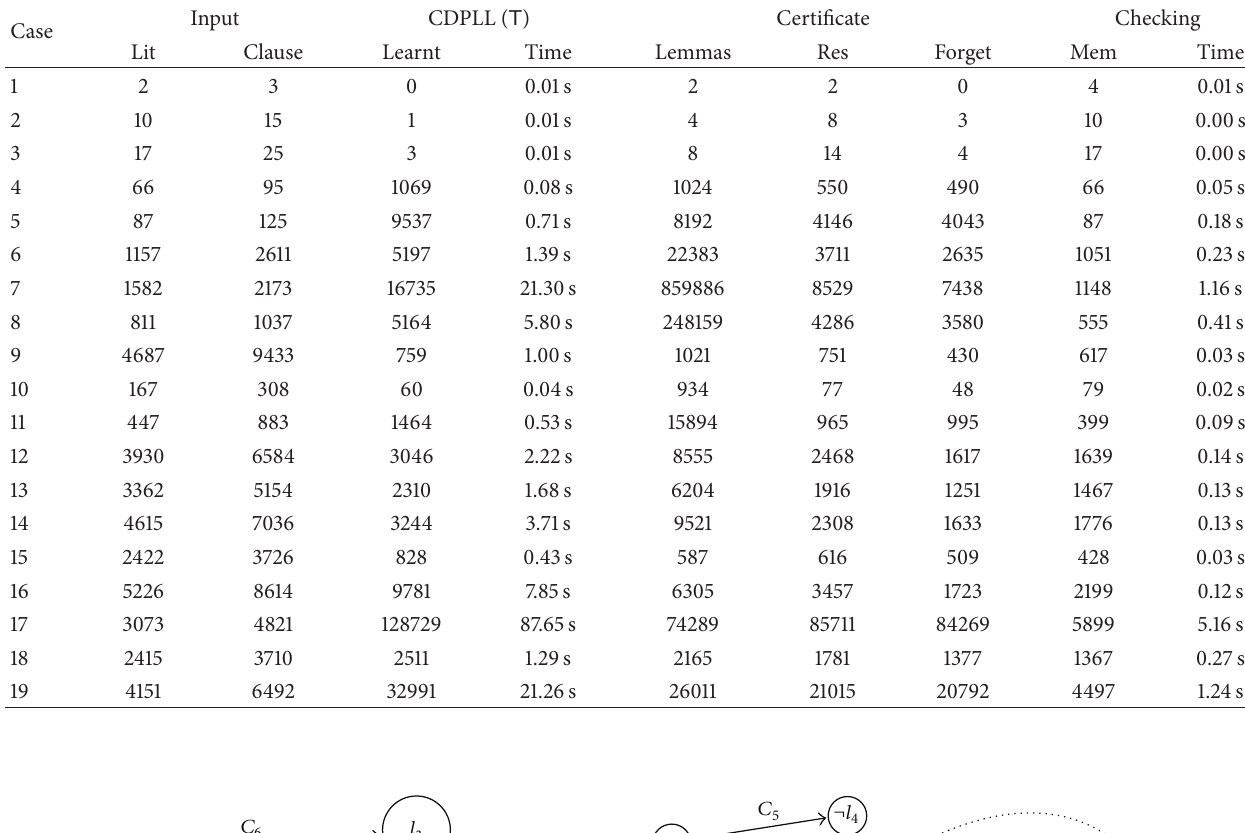
Table 4: Experiment results.